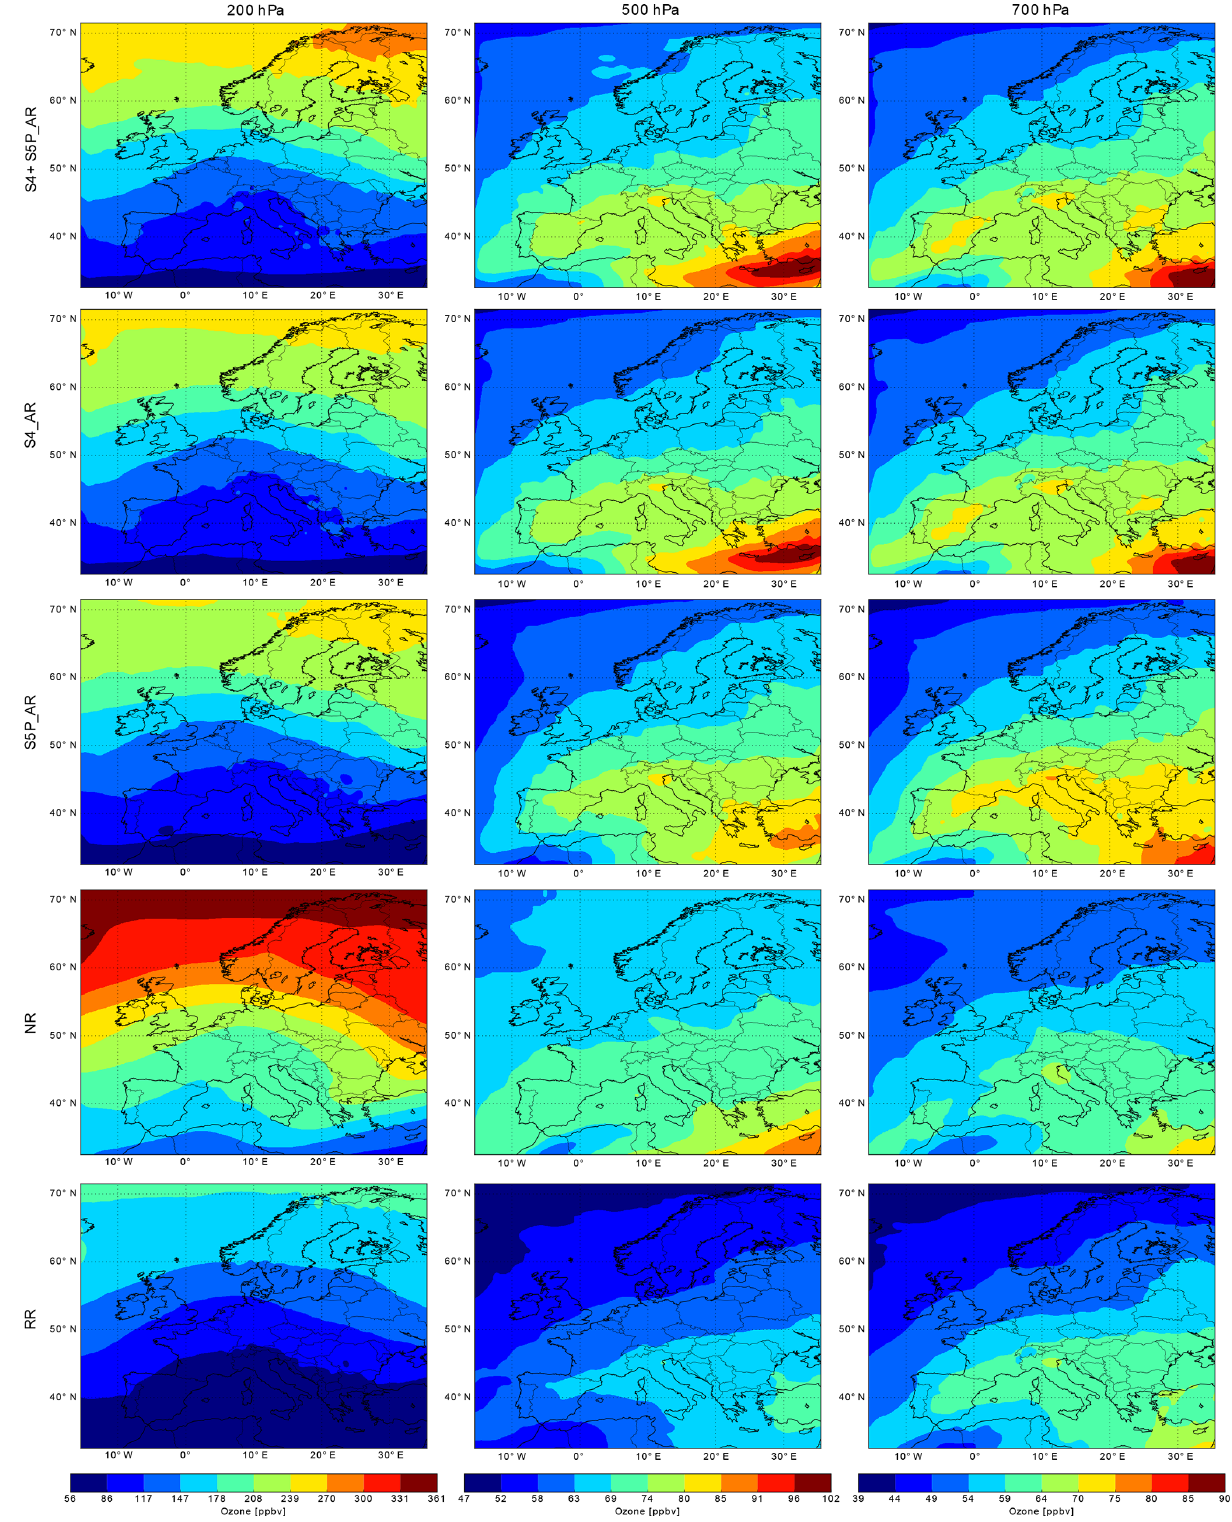
Figure 9. Mean ozone fields (ppbv) for summer 2003 over the European domain at 200hPa (left column), 500hPa (middle column), and 700hPa (right column), as simulated by the S4+S5P_AR, the S4_AR, the S5P_AR, the nature run, and the reference run (from top to bottom rows). Note that the colour bars for the three levels are different. The red (blue) end of the colour scale represents relatively large (small) ozone